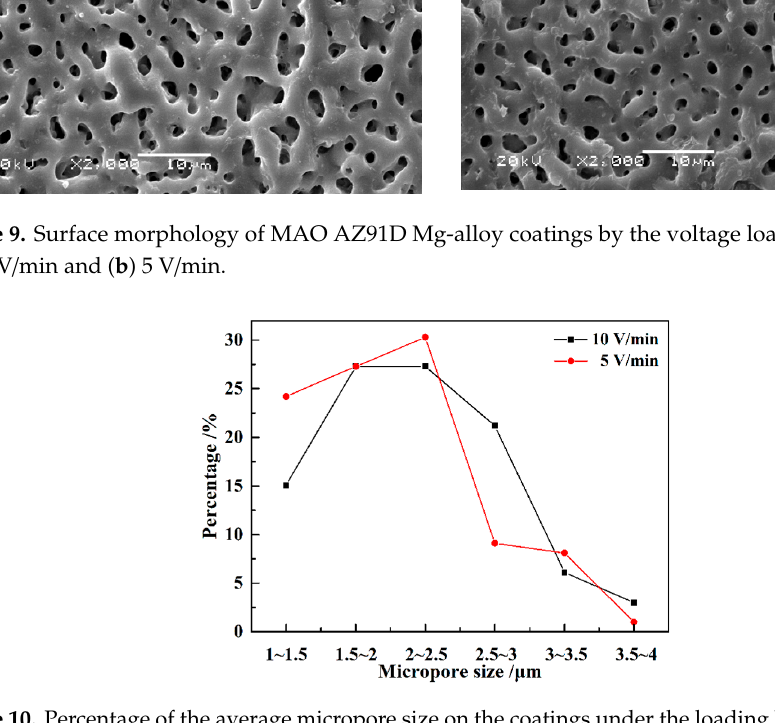
Figure 10. Percentage of the average micropore size on the coatings under the loading level at 10 V/min and 5 V/min.